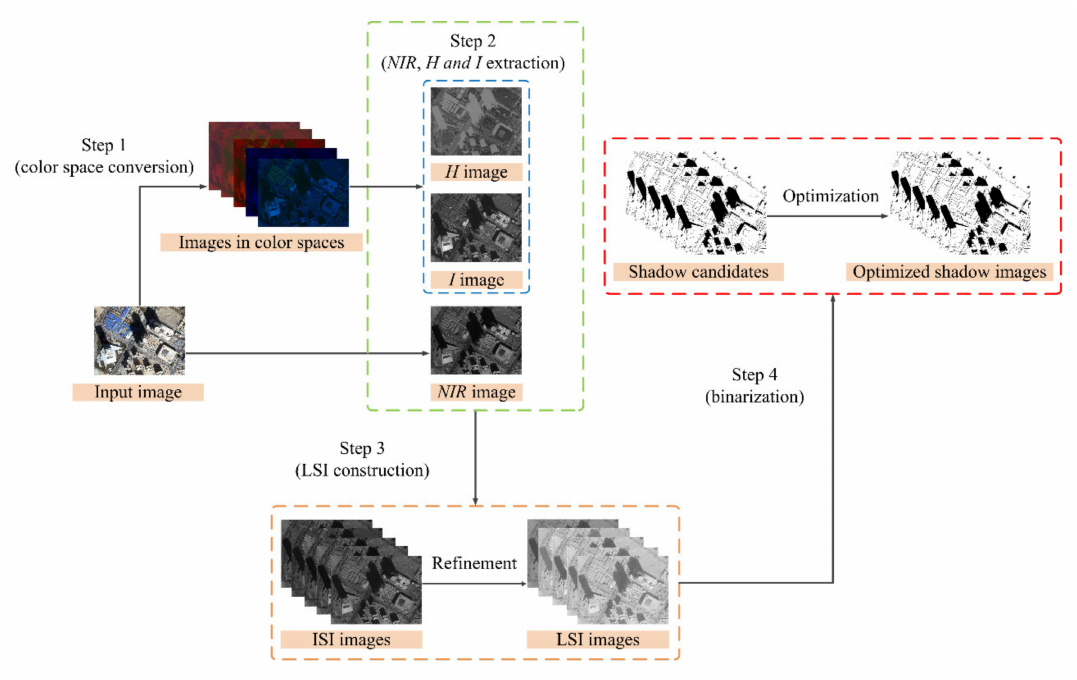
Figure 1. The flow chart of the logarithmic shadow index ( LSI ) shadow detection